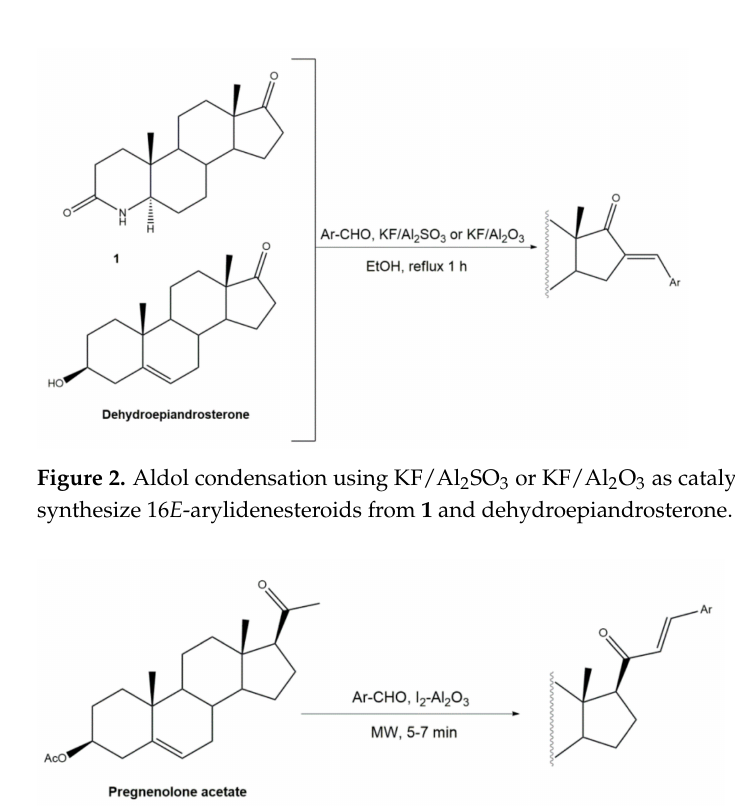
Figure 3. Preparation of 21 E -arylidenepregnenolone acetate derivatives, catalyzed by I 2 -Al 2 O 3 under microwave irradiation [52].